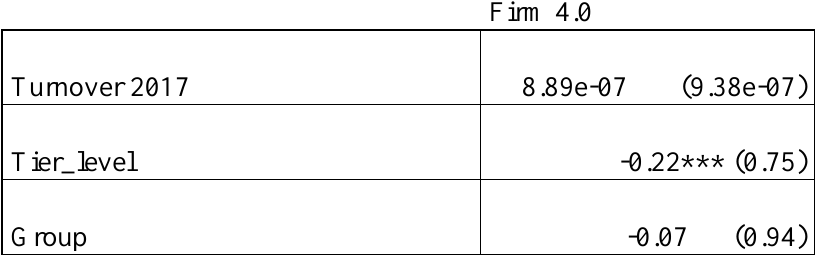
Table 5: Probit Model, With Robust Errors, that Correlates the Probability of Being a Firm 4.0 with the Identified Explicative